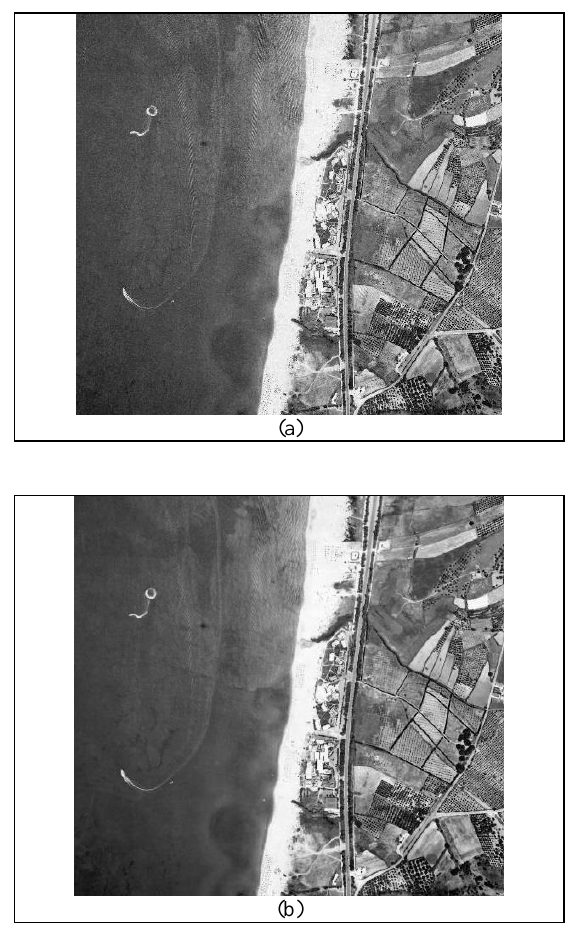
Figure 2. Result of pre-processing: (a) initial image, (b) image after applying Gaussian filter and anisotropic